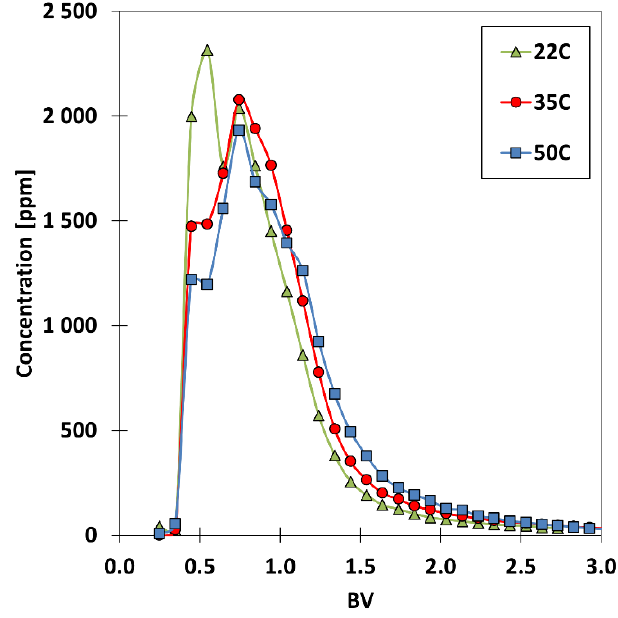
Figure 5. Effect of temperature on the retention of the MGDA –REE complexes shown as Σ[REE] (resin = IRA – 410; flowrate = 2.98 BV/h; feed (#2) = 0.05 BV, eluent = 50 mM HCl).